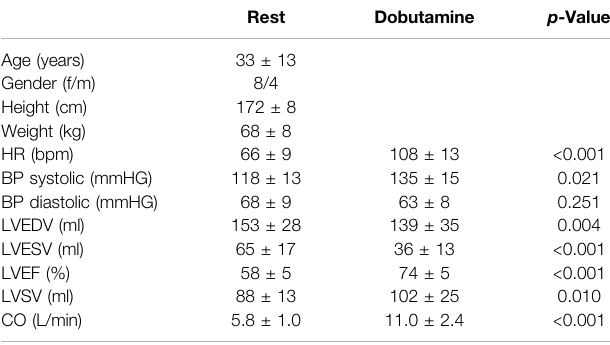
TABLE 3 | Hemodynamic parameters for all regions of the thoracic aorta.